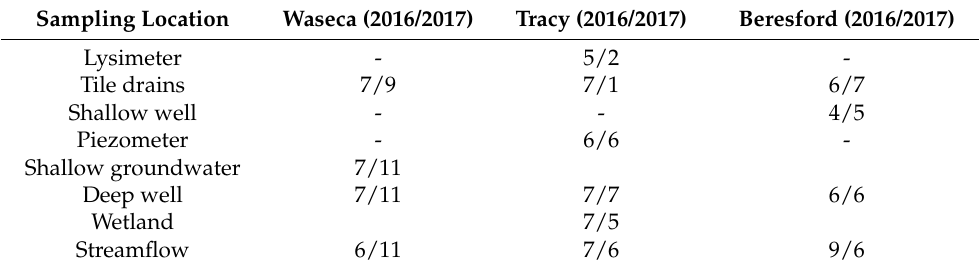
Table 2. Number of samples collected in 2016/2017 at each site for each location. Sampling